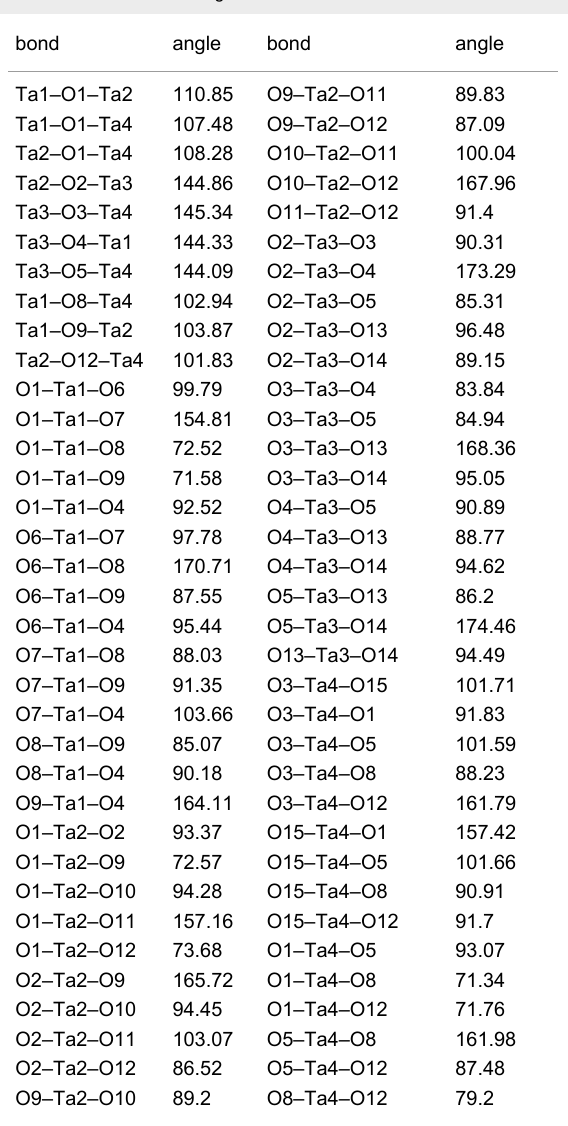
Table 2: Selected bond